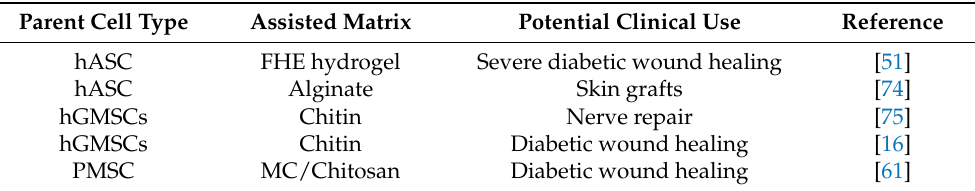
Table 3. Stems cells combined with hydrogel matrices with their corresponding clinical/in vivo uses in soft tissue regeneration. Parent Cell Type Potential Clinical Use hASC [51] hASC [74] Chitin Nerve repair Chitin Diabetic wound healing PMSC